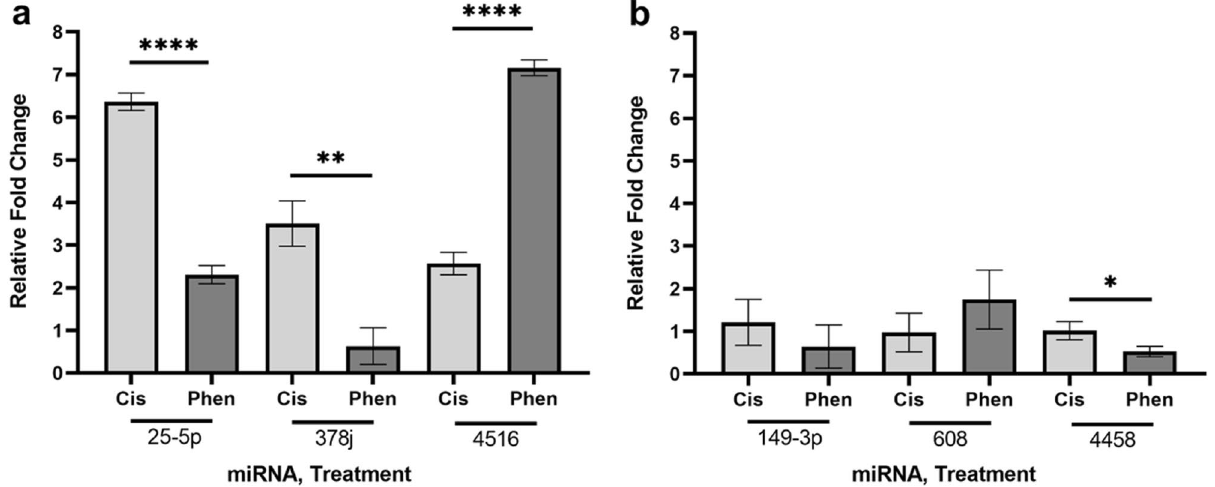
Figure 3. Measurement of miRNA expression using qRT-PCR. ( a ) A549 cell line results for miR- 25-5p, -378j and -4516. ( b ) IMR90 cell line results for miR-149-3p, -608 and -4458. Key: “cis” = cisplatin; “phen” = phenanthriplatin. Error bars represent mean ± standard deviation, N = 3, “*” = p ≤ 0.05; “**” = p ≤ 0.01; “****” = p ≤